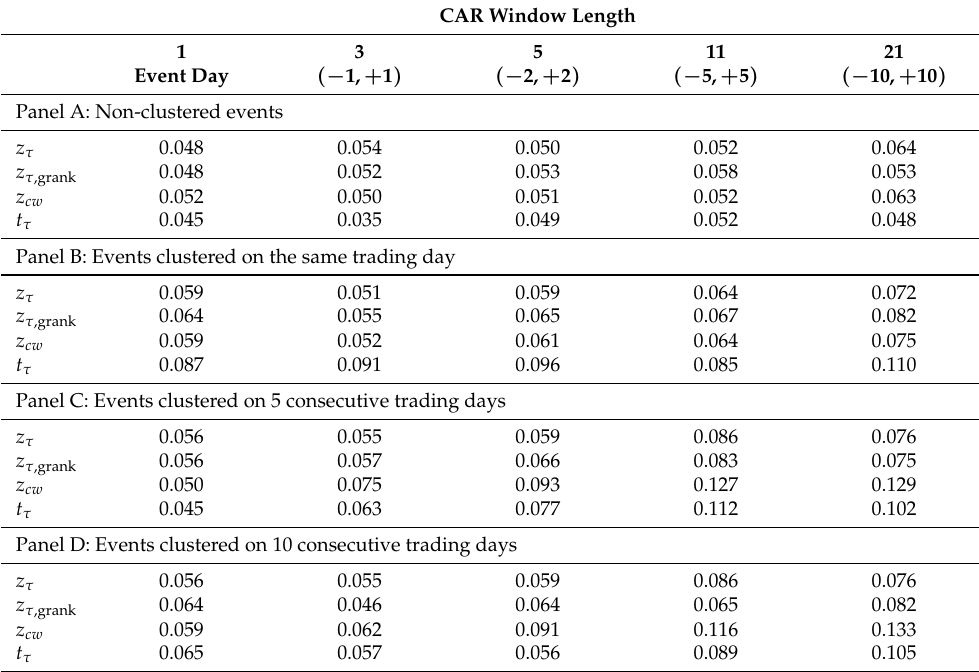
Table 2. Rejection rates of the null hypothesis of no event effect at the nominal 5% level when the events are no-overlapping, partially overlapping, and completely